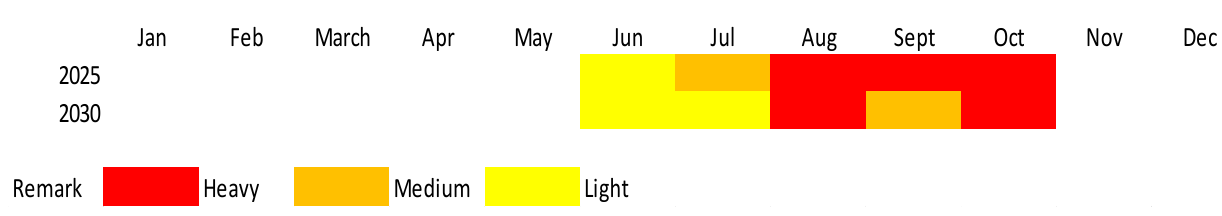
Figure 9. Drought criteria pattern in 2025 and 2030 based on the simulation with scenario one in the Dodokan Watershed.